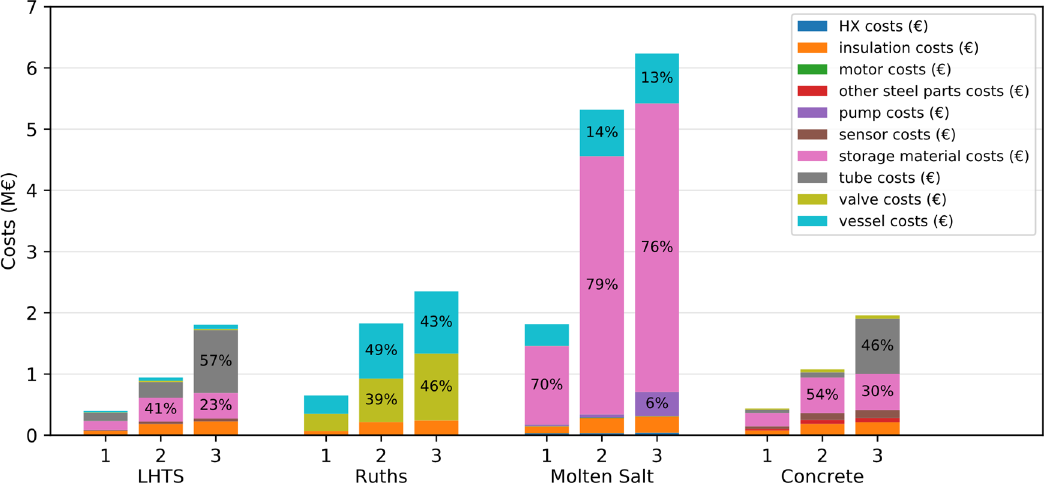
Figure 14. Cost structure for all selected TES technologies for Case 2 for three capacity (Cap.)/heat load (HL) scenarios—1: Low Cap./Low HL, 2: High Cap./Low HL, 3: High Cap./High HL.